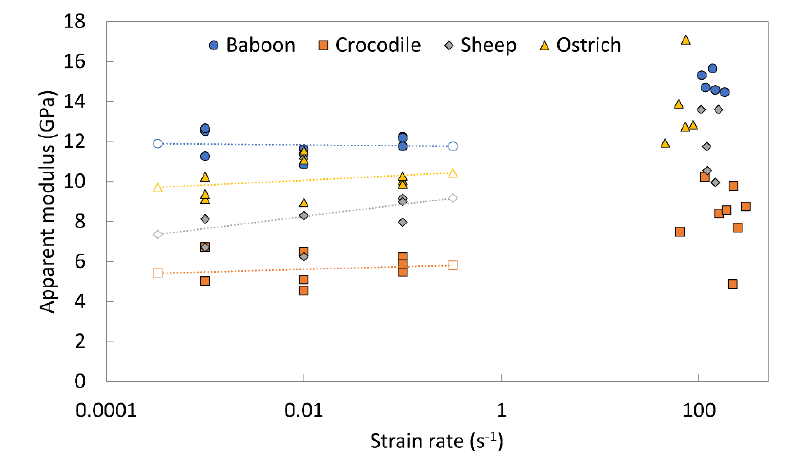
Figure 3 : Comparison of apparent moduli for all species across all strain rates